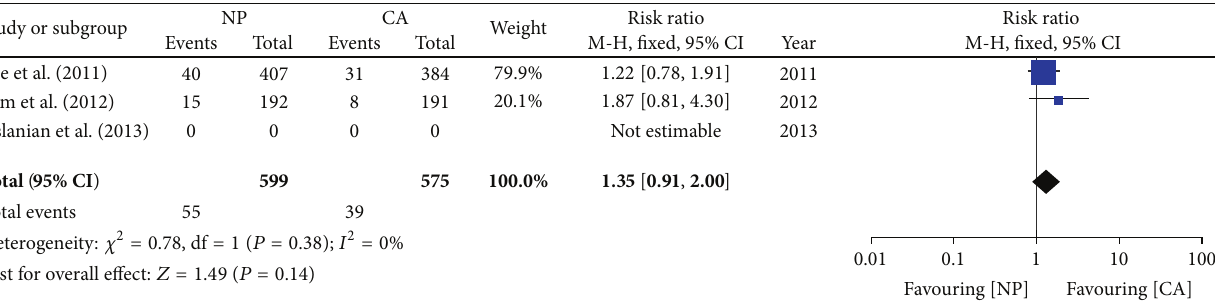
Figure 5: Forest plot on the advanced lesions detection rate comparing NP versus